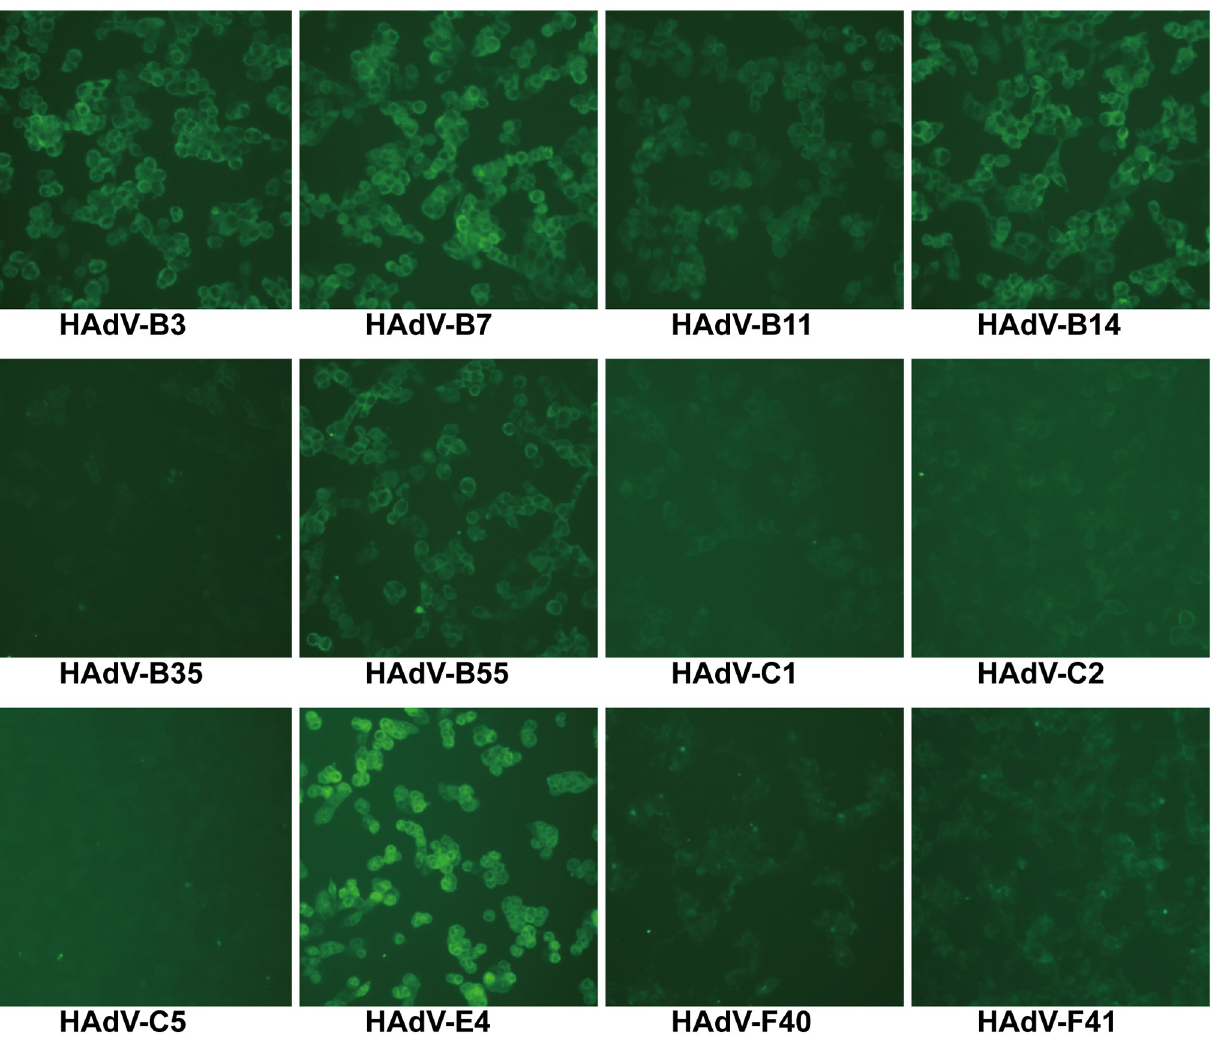
Fig 5. Immunofluorescence analysis of Fab 4E2 with different types of HAdV-infected cells. HAdV-B3, B7, B11, B14, B35, B55, C1, C2, C5, E4, F40, and F41 were individually used to examine Fab 4E2 with HAdV-infected cells using immunofluorescence. Cell cultures with obvious CPE were visualized. The cells were observed by a fluorescence microscope (100 ×